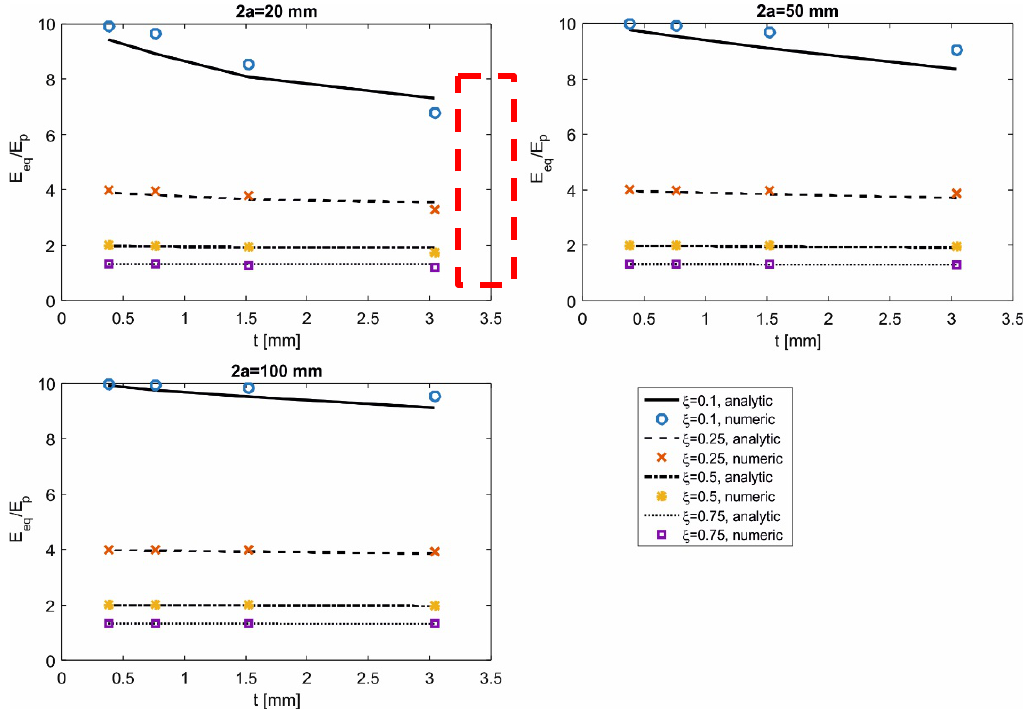
Fig. 7 Ratio E eq / E p , as a function of the interlayer thickness, for different values of percentage of detached interlayer ξ = λ / a of the fragment length 2 a